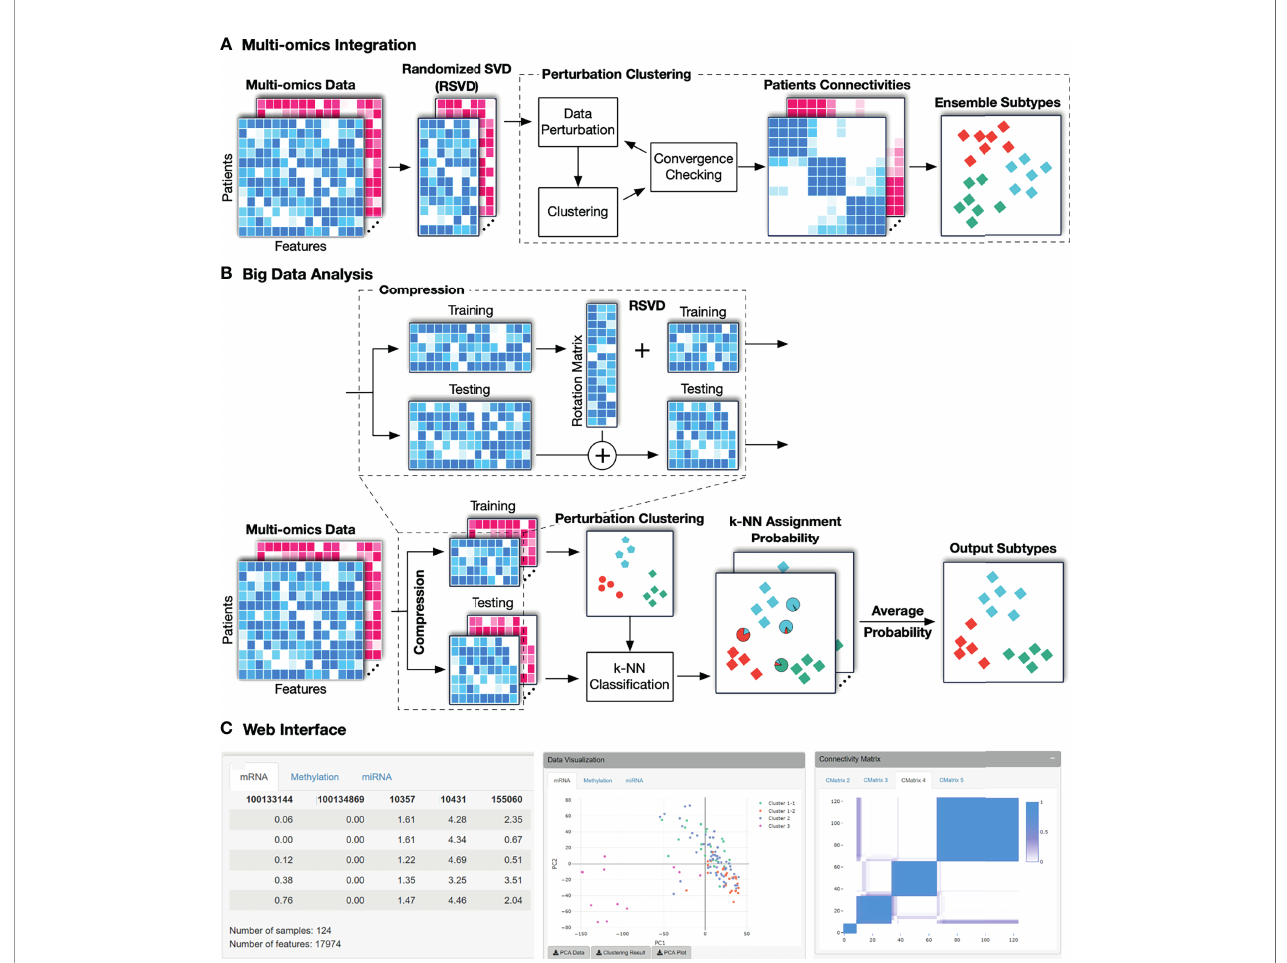
FIGURE 1 | The overall work fl ow of SMRT. (A) Analysis pipeline for data with moderate size. First, SMRT projects each data type to a lower-dimensional space using randomized singular value decomposition (RSVD). Next, it performs a perturbation clustering to determine the subtypes, and to build a pair-wise patient connectivity for each data type. Finally, it merges the connectivity matrices onto a single similarity matrix and then determines the fi nal subtypes using a cluster ensemble. The output is the clustering results for each data type, as well as the results after the multi-omics data integration. (B) Analysis pipeline for big data. SMRT fi rst splits the data into two different sets: a sampled and a propagated set. The method fi rst determines the subtypes using the sampled set and then assigns the patients from the propagated set to subtypes identi fi ed using the sampled set. The sampled data is partitioned using the pipeline described assignments for samples in the propagated set are determined by averaging the probabilities from all k-NN models. (C) An example of the subtypes discovered by the SMRT web service for the KIRC dataset. The left panel shows a preview of the uploaded data. The middle panel shows the visualization of the discovered subtypes and export functions. The right panel shows patient connectivity matrices for each data